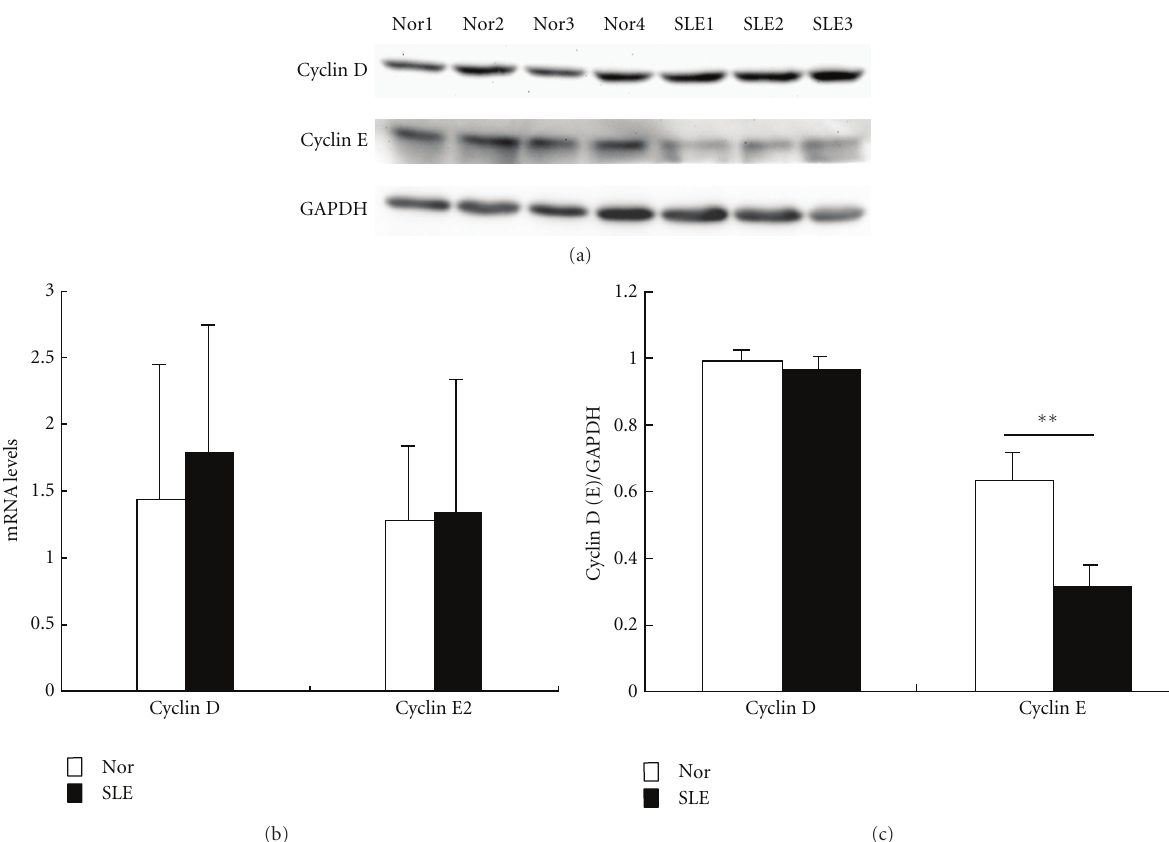
Figure 4: mRNA and protein levels of cyclin D and cyclin E in BMMSCs from SLE patients. (a) Immunoblotting analysis of cyclin D and cyclin E. (b) qRT-PCR studies of the expression of cyclin D and cyclin E2 in BMMSCs from SLE and normal controls ( n = 5, P > 0 . 05). Results were shown as mean ± SEM, each performed with triplicate samples. (c) Quantity analysis showed low protein level of cyclin E in cells from SLE patients, ∗∗ P < 0 . 01 by Student’s t -test. SLE: systemic lupus erythematosus, Nor: normal